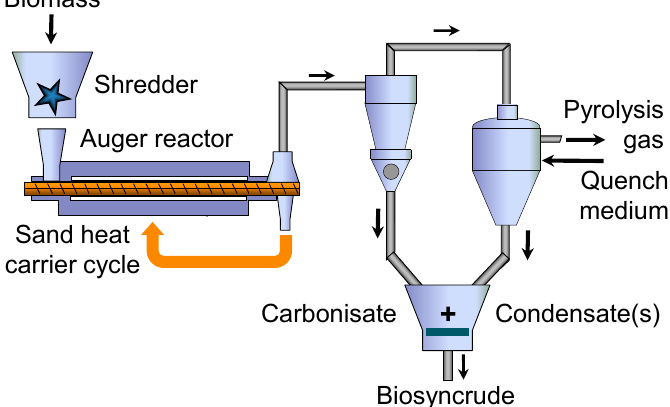
Figure 1. Schematic of the de-centralized fast pyrolysis process.